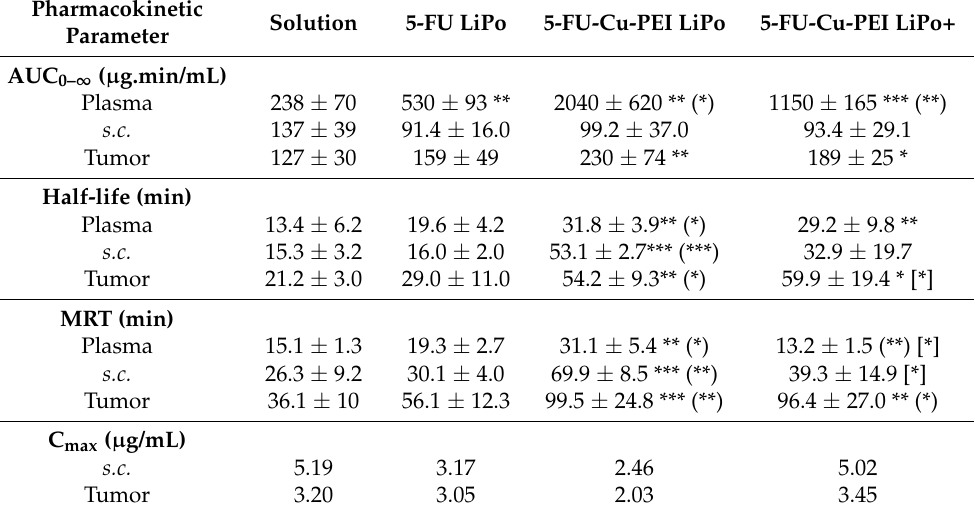
Table 1. Comparison of pharmacokinetic parameters for 5-FU with respect to concentrations in plasma and extracellular fluid from healthy s.c. tissue and tumor tissue following an i.v. dose of various 5-FU formulations. Data represent mean ± S.D. ( n =